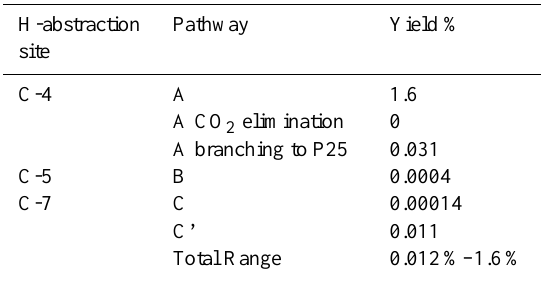
Table 4. Theoretical Yields of MBTCA formation by oxidation of pinonic acid via different